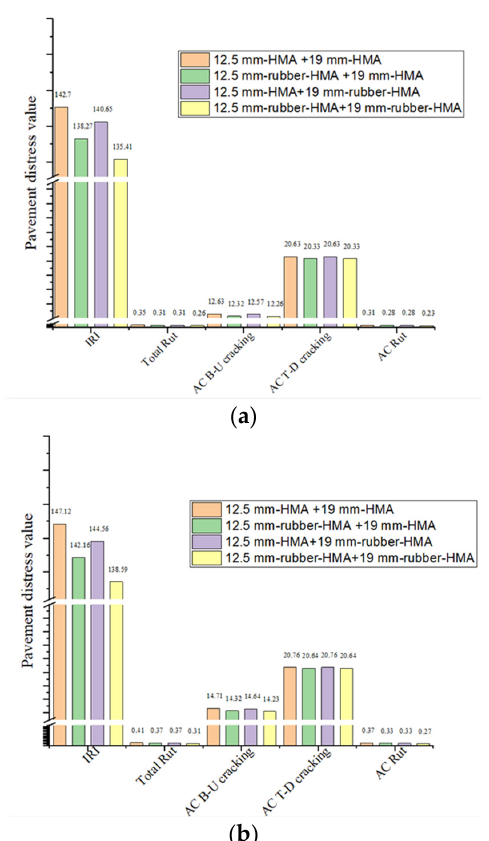
Figure 11. Results of pavement distress for several types of HMA. Note: international roughness index (IRI), AC (bottom-up) B-U cracking, AC (top-down) T-D cracking. ( a ) Pavement distress results (AADTT = 1000); ( b ) pavement distress results (AADTT = 2000). Table 4. Pavement M-E input for 12.5 mm- HMA.